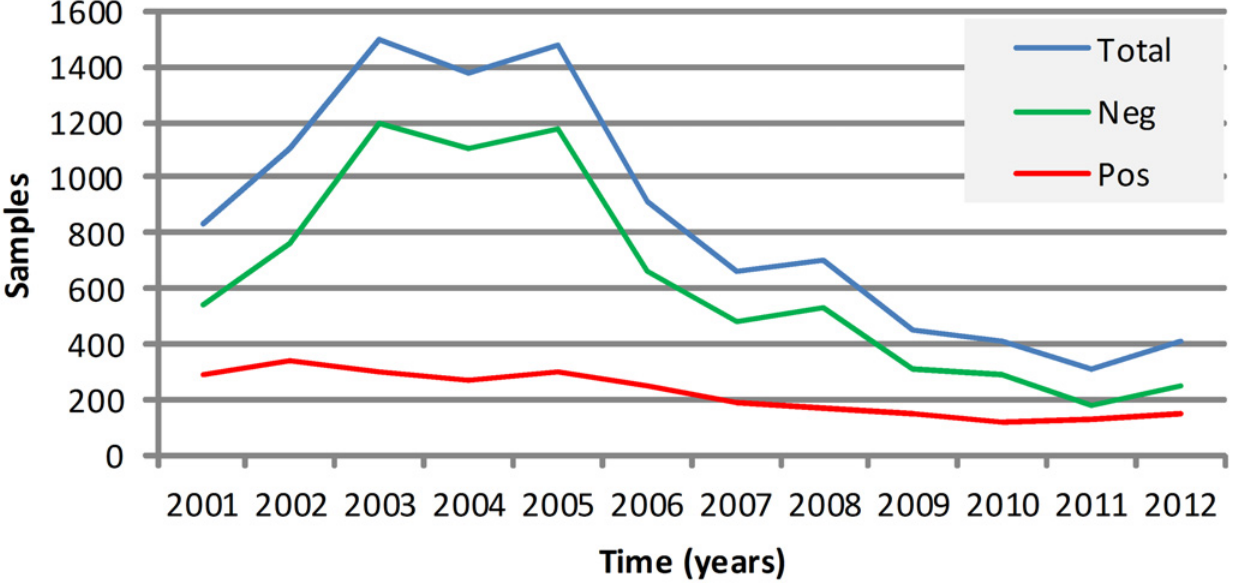
Fig 4. Overall trend of positive, negative and total animal rabies diagnoses performed in Minas Gerais, Brazil, from 2001 to 2012.